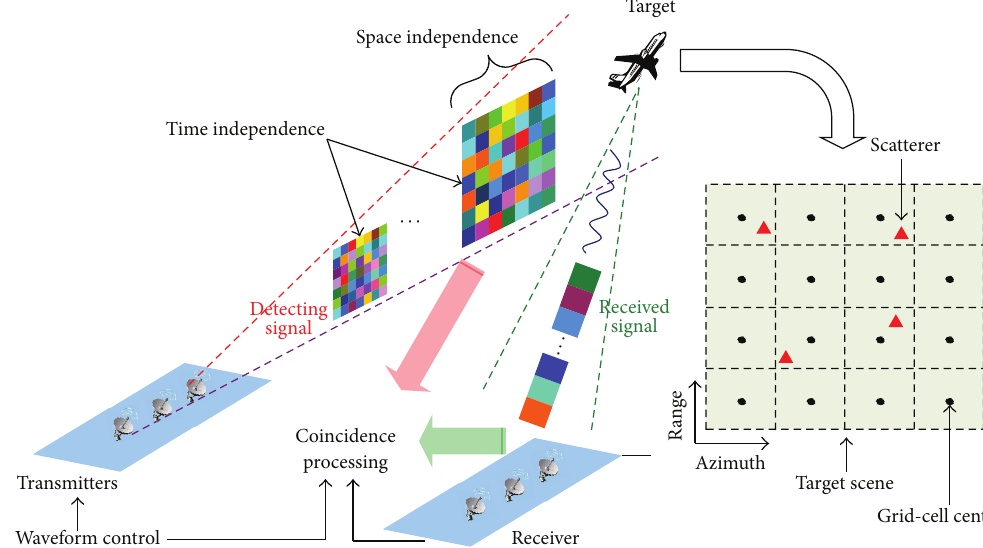
Figure 1: Geometry of off-grid